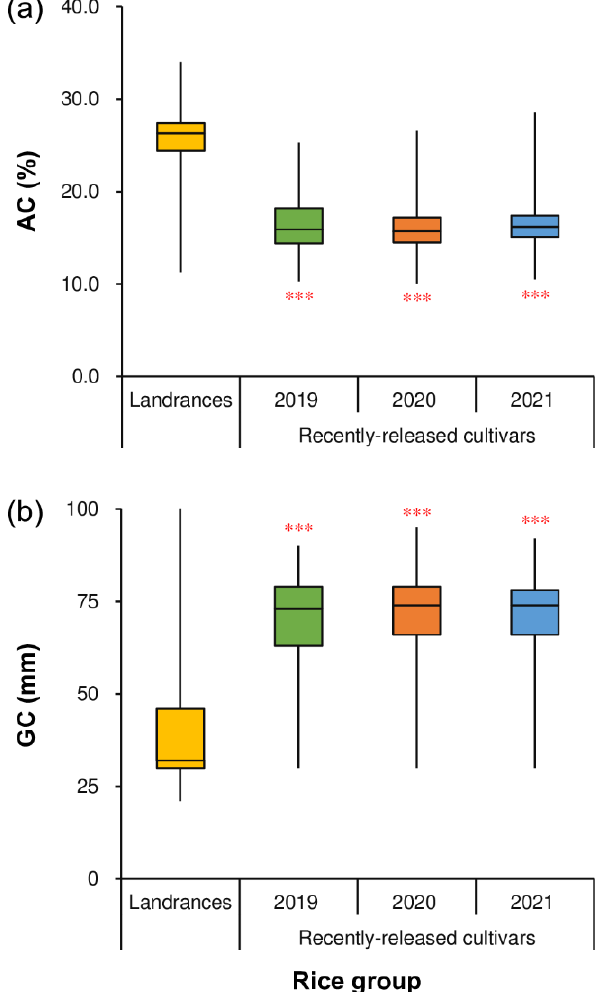
Figure 1. ( a ) Amylose content (AC) and ( b ) gel consistency (GC) in landraces and recently-released cultivars of indica rice in China. The box-and-whisker plot shows the minimum (end of the lower whisker), 25th percentile (lower edge of the box), median (horizontal line within the box), 75th percentile (upper edge of the box), and maximum (end of the upper whisker) values of the data ( n = 706, 474, 645, and 717 for landraces and cultivars released in 2019, 2020, and 2021, respectively). *** denotes a significant difference between recently-released cultivars and landraces at the 0.001 probability level.